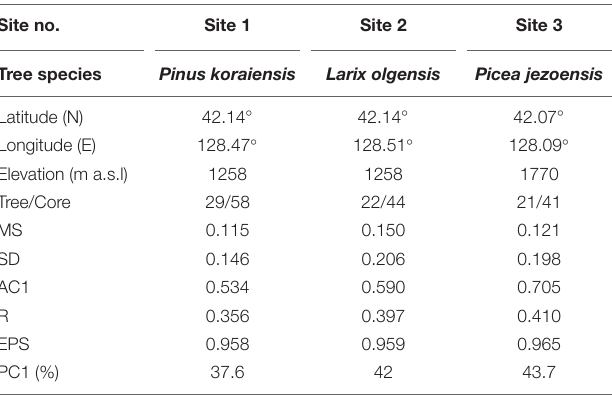
MS indicates the mean sensitivity, SD the standard deviation, AC1 the first- order autocorrelation, R the mean correlation between trees, EPS the expressed population signal, and PC1 the first principal